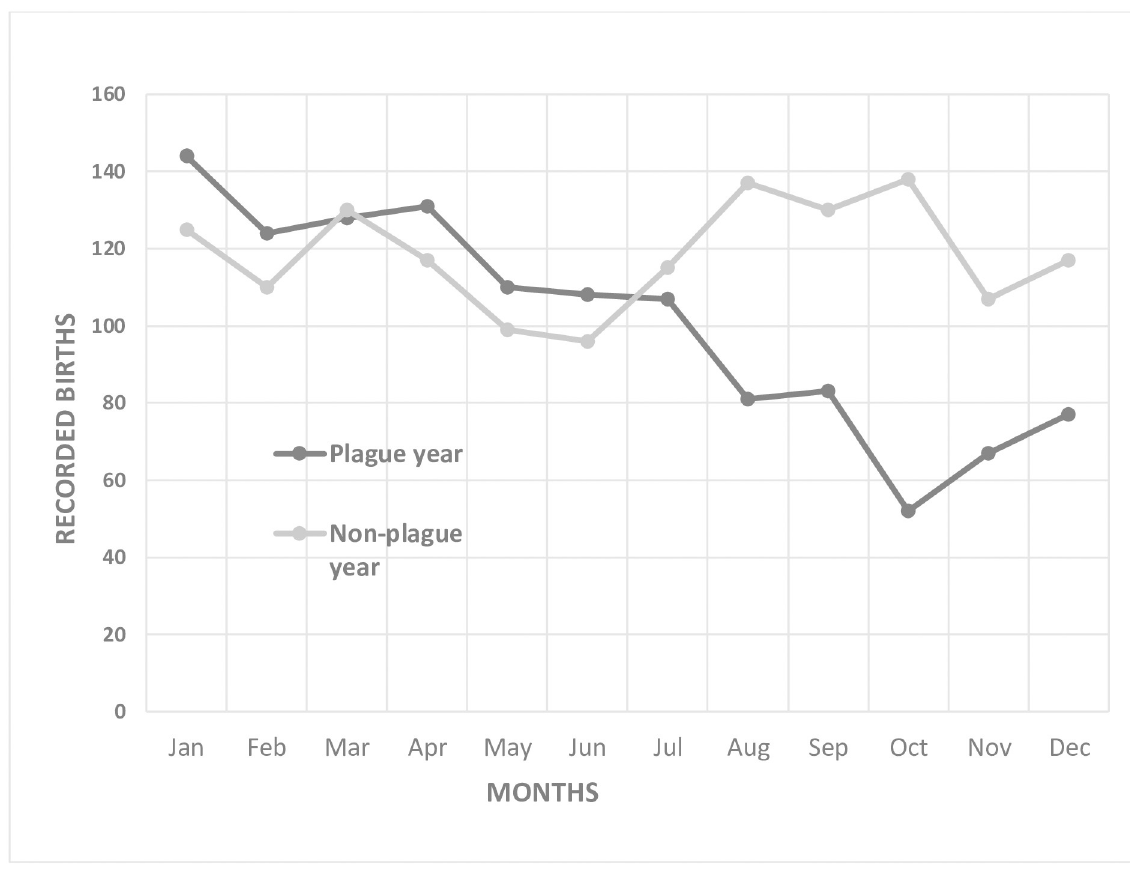
Fig 2. Total of monthly recorded births in sixteen central London parishes in five plague years compared to the monthly recorded births for the five years immediately preceding plague years. https://doi.org/10.1371/journal.pone.0272278.g002 and ‘chrisoms’ (live births of children which died before baptism) could be significant factor. However, in our sample there were only 16 of these in 1602 and 23 in 1603, indicating that these relatively rare events played only a small part in the overall statistics for that plague-year.